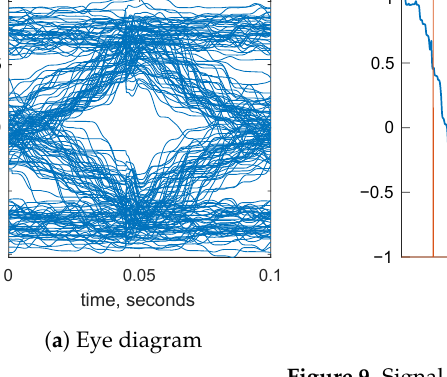
Figure 9. Signal at the input of decision-making unit.